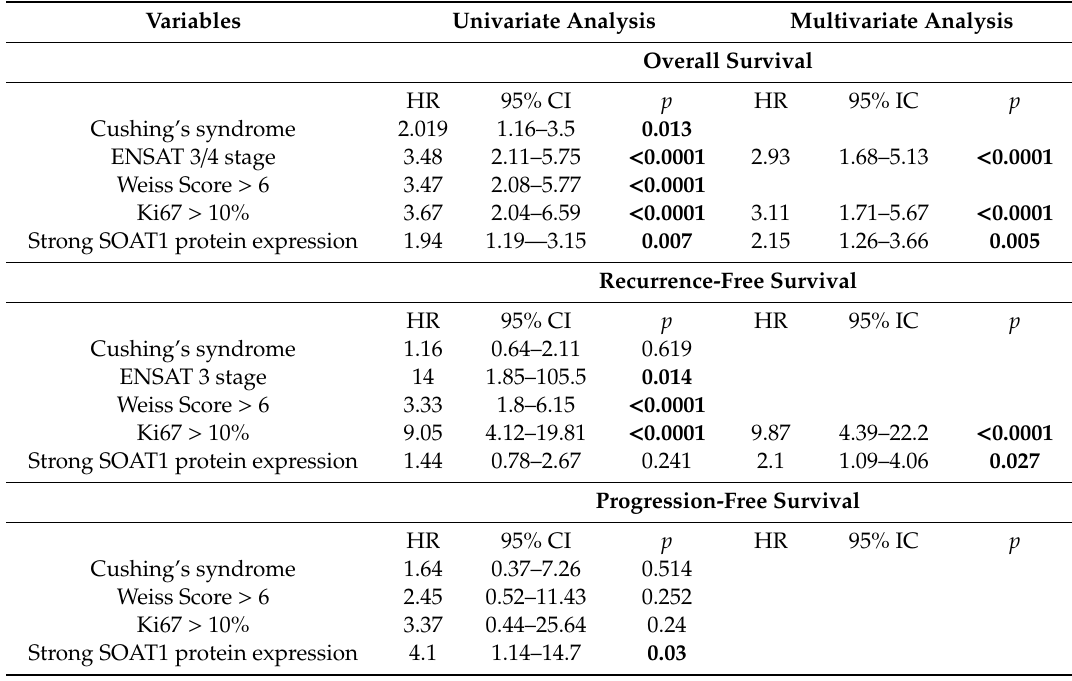
Table 3. Prognostic factors for overall survival, recurrence-free survival, and progression-free survival in adult patients with ACC (only tumor samples derived from primary